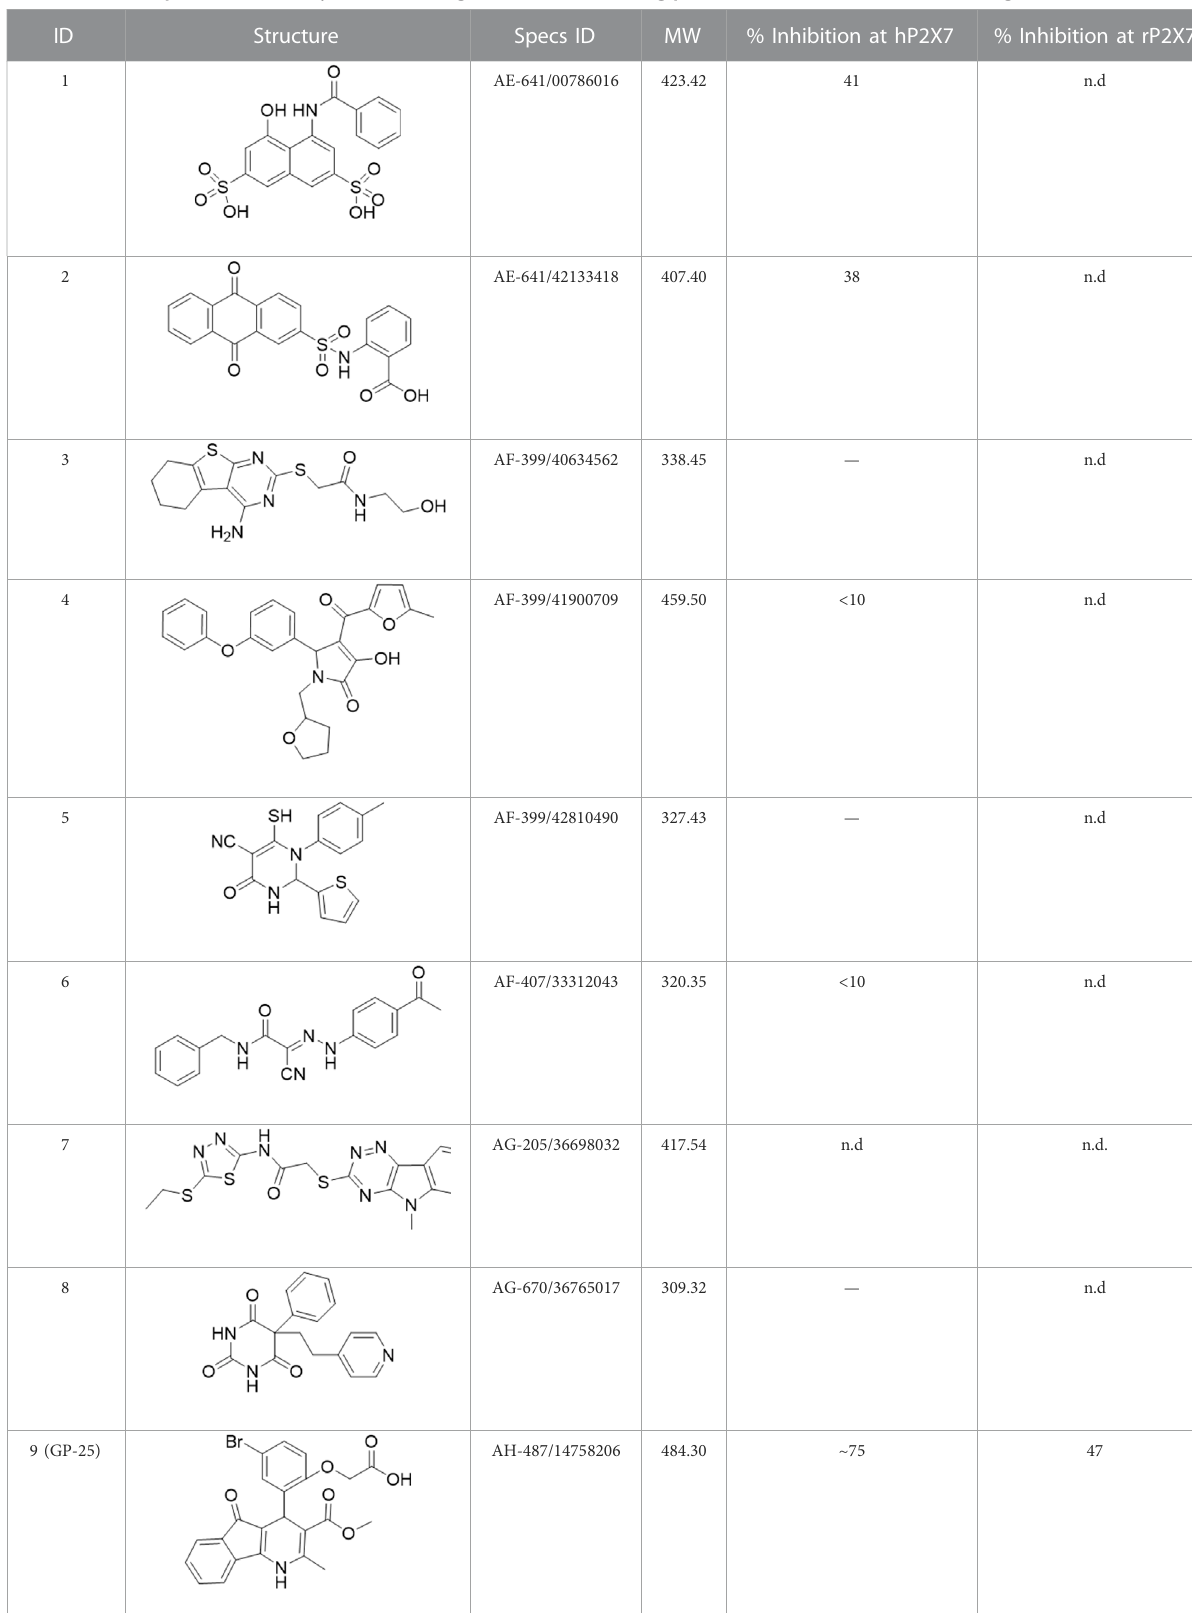
TABLE 1 List of compounds identi fi ed by virtual screening in the P2X4 ATP-binding pocket (numbered 1 – 17) and GP-25 analogues (numbered 18 –